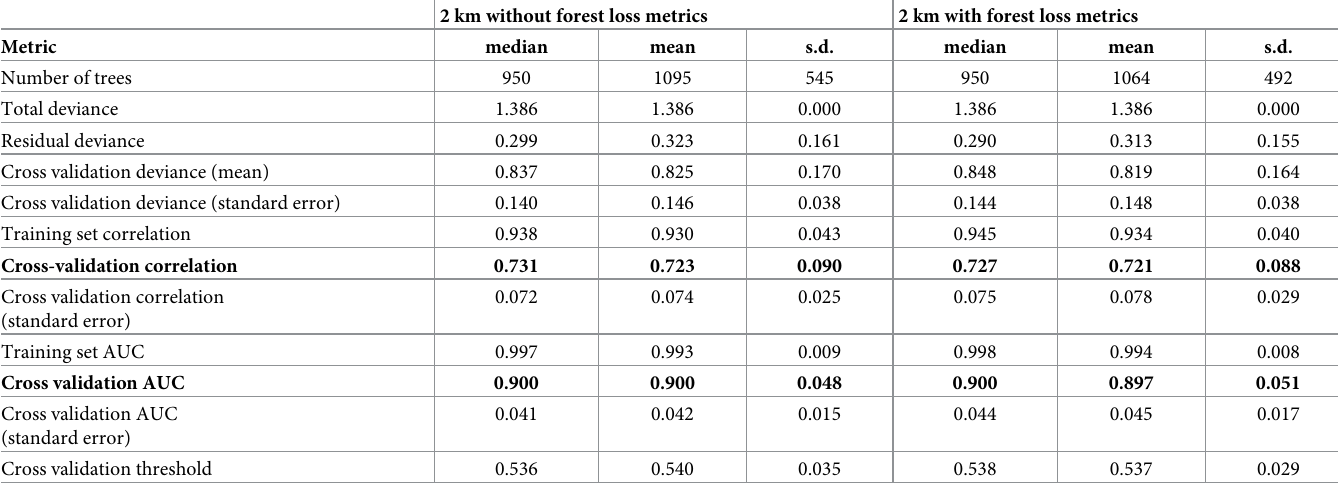
Table 4. Accuracy metrics for BRT models of Kyasanur Forest Disease distribution—2 km resolution. 2 km without forest loss